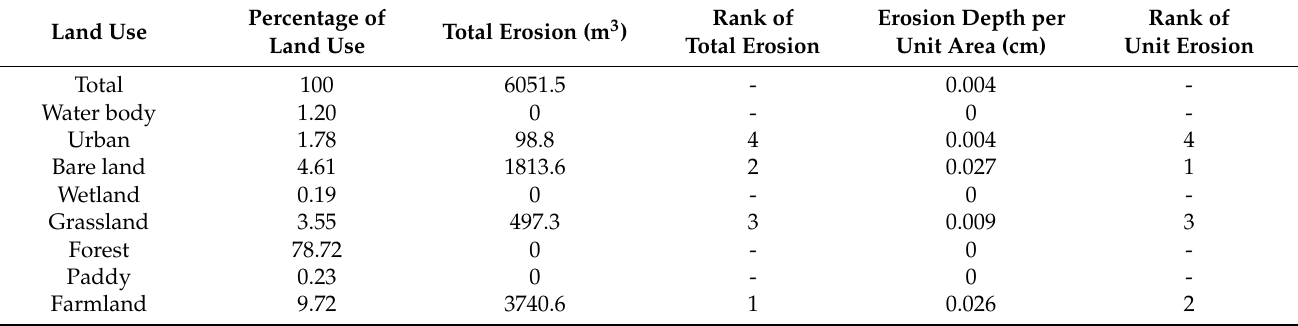
Table 5. Results of erosion for land use (MR-SSEM).